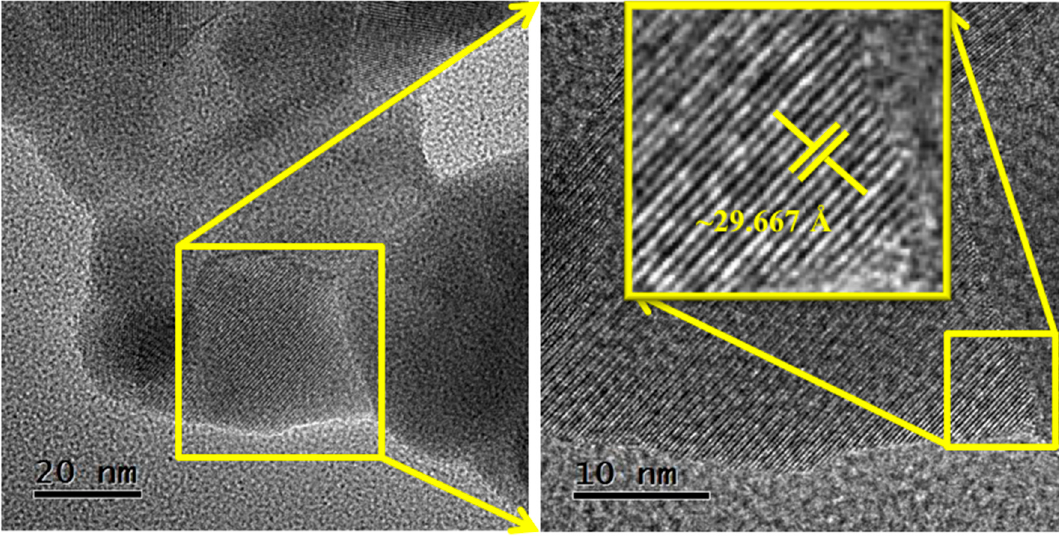
Figure 7. High resolution TEM (HRTEM) images showing the crystal planes of the manganese antimonate nanoparticles.